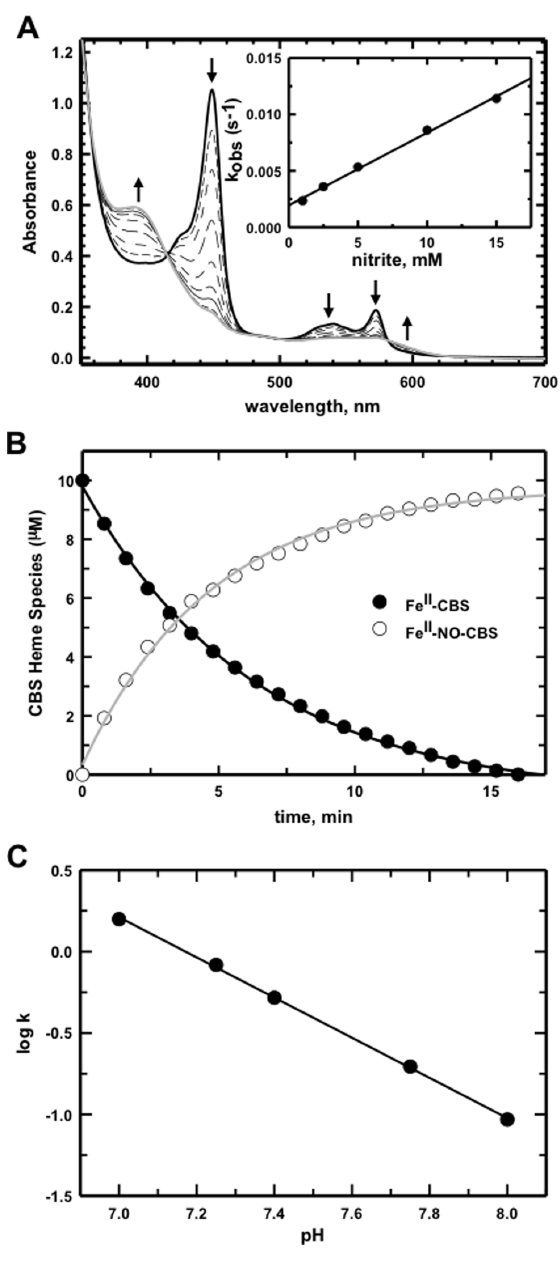
Figure 1. Nitrite reduction by Fe II -CBS. ( A ) UV-visible spectra recorded every minute under anaerobic conditions for the reaction between Fe II -CBS (10 m M, generated by reduction of Fe III -CBS with 3 mM dithionite) and nitrite (10 mM) in 0.1 M HEPES buffer, pH 7.4, at 37 u C. ( Inset ) The observed reaction rate for CBS-catalyzed reaction as a function of nitrite concentration. ( B ) The disappearance of Fe II -CBS (formed by reduction of Fe III -CBS (10 m M) with dithionite (3 mM)) was monitored at 449 nm (filled circles) and paralleled the formation of Fe II - NO-CBS in the presence of 10 mM nitrite (open circles) monitored at 394 nm. The solid lines represent single exponential fits to the experimental data points. ( C ) Dependence of nitrite reduction by Fe II - CBS on pH. Reaction of Fe II -CBS (10 m M) generated by the reduction of Fe III -CBS with dithionite (3 mM) in 0.1 M HEPES pH 7.0, 7.25, 7.4, 7.75 and 8.0 at 37 u C with nitrite (10 mM) was monitored at 449 nm. Reaction rates corrected for the percentage of reduced protein at each pH were plotted as a function of pH. The slope obtained from a linear fit was 1.2 6 0.03.